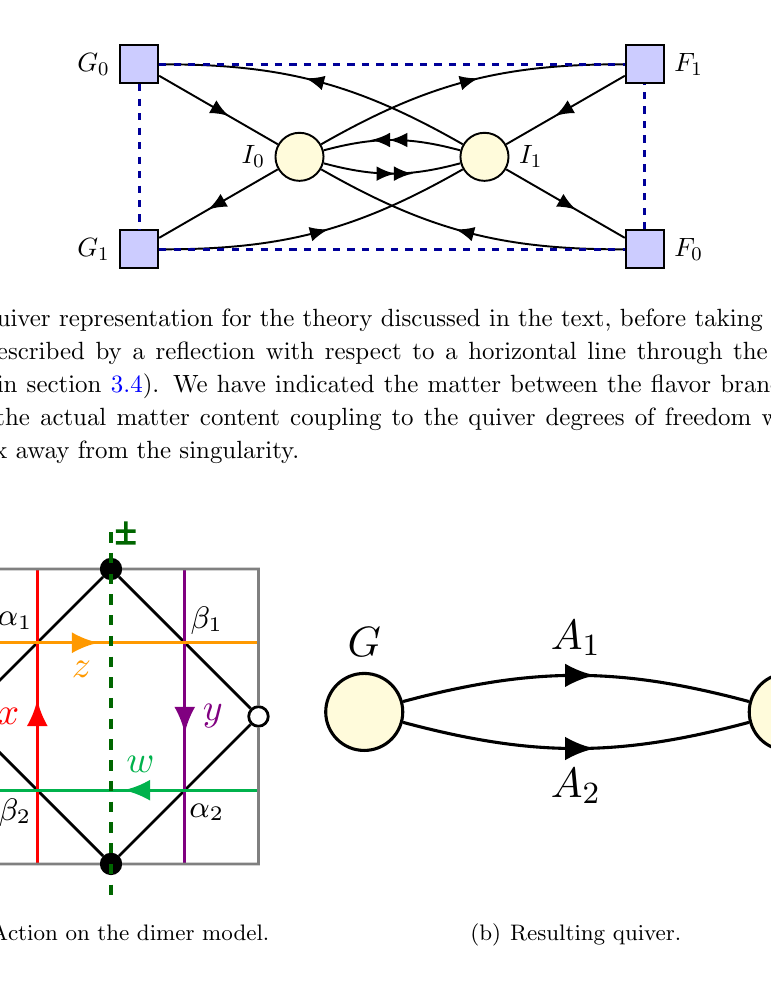
Figure 3 . Action of the orientifold studied in the text on the quiver theory of the conifold. (a) The action on the dimer model [74{76] is given by a line orientifold, in the terminology of [78]. The choice of equal signs for the two (cid:12)xed lines is associated with having an O7 plane instead of an O3 plane. (b) Resulting quiver gauge theory. We will determine in the text that G = USp (2 N